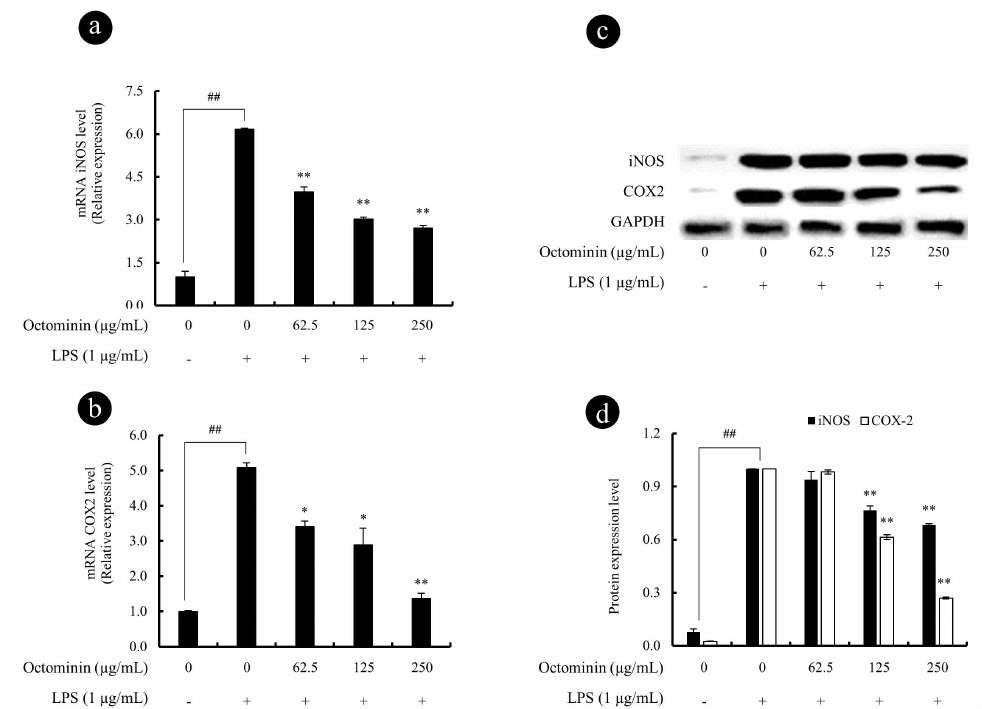
Figure 5. Octominin inhibits the iNOS and COX2 secretion from LPS-activated RAW 264.7 macrophages. The gene expression analysis of iNOS ( a ) and COX2 ( b ) was measured using qPCR with GAPDH as the internal reference gene. The 2 − ∆∆ Ct method was used to calculate the relative mRNA expression levels. Experiments were triplicated. mRNA significance relative to the non-treated control was calculated using the Mann–Whitney U test. Western blots were used to determine the protein expression levels of iNOS and COX2 ( c ), the related expression of the bands was analyzed using ImageJ software ( d ), and β -actin was used as internal control. Results are expressed as the mean ± SD of three separate experiments. Statistical significance was determined versus vehicle-treated control group ( # < 0.05 and ## < 0.01) or LPS-treated group (* < 0.05 and ** <